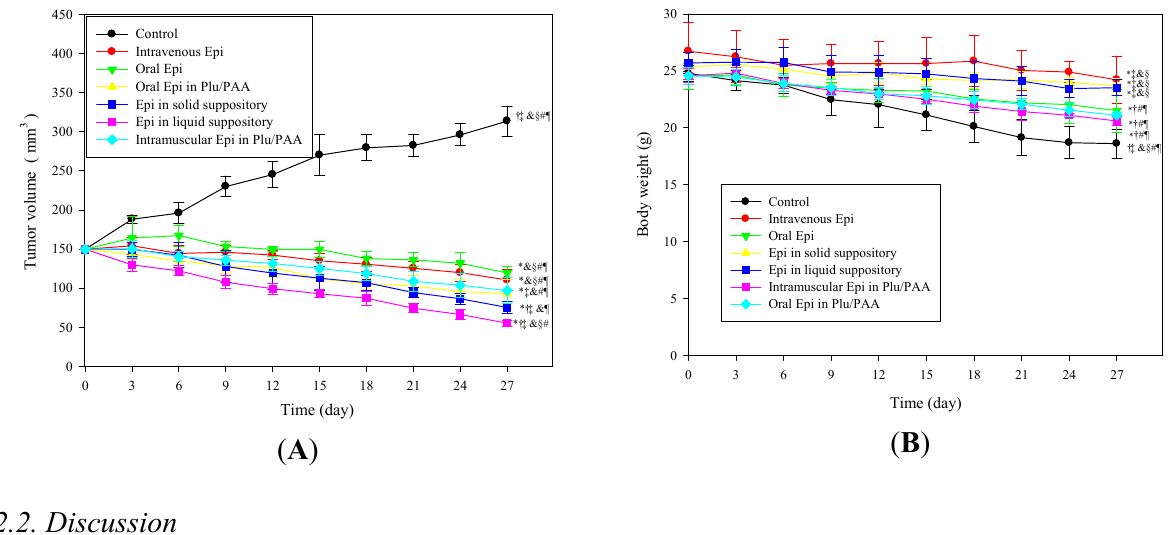
Figure 7. In vivo ( A ) antitumor efficacy and ( B ) the body weight (g) of Epi (50 μ g/mL) administered in different formulations as a function of time in CT26 bearing